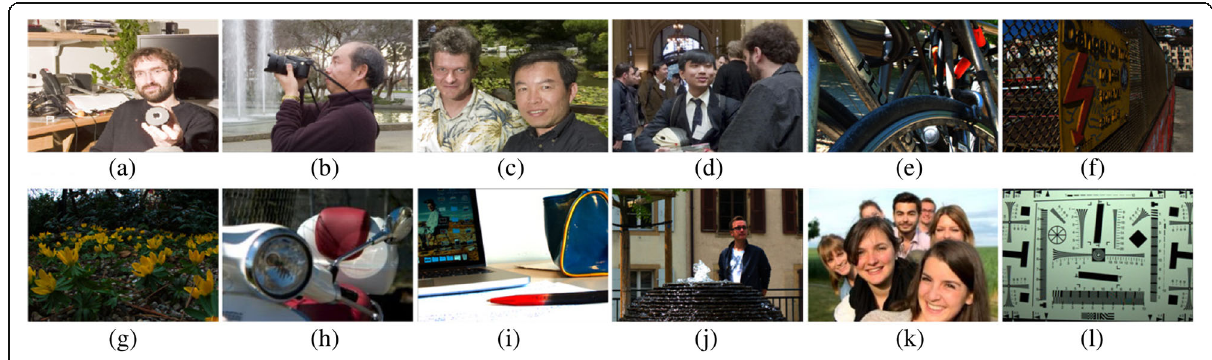
Fig. 5 The central rendered views from each LF test image: a Fredo, b Jeff, c Sergio, d Zhengyun1, e I01_Bikes, f I02_Danger_de_Mort, g I03_Flowers, h I05_Vespa, i I07_Desktop, j I09_Fountain_&_Vincent_2, k I10_Friends_1, l I12_ISO_Chart_12